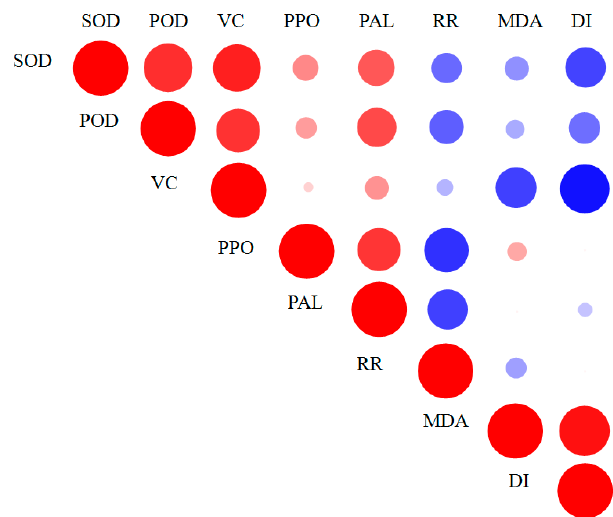
Figure 6. Correlation matrix based on Pearson’s correlation coefficient between the defensive enzyme (superoxide dismutase (SOD), peroxidase (POD), polyphenol oxidase (PPO), and phenylalnine ammonia-lyase (PAL)) activity, respiration rate (RR), MDA content, and decay incidence (DI). Positive correlations are displayed in red and negative correlations in blue. Numerical values and the color intensity are proportional to the correlation coefficient.